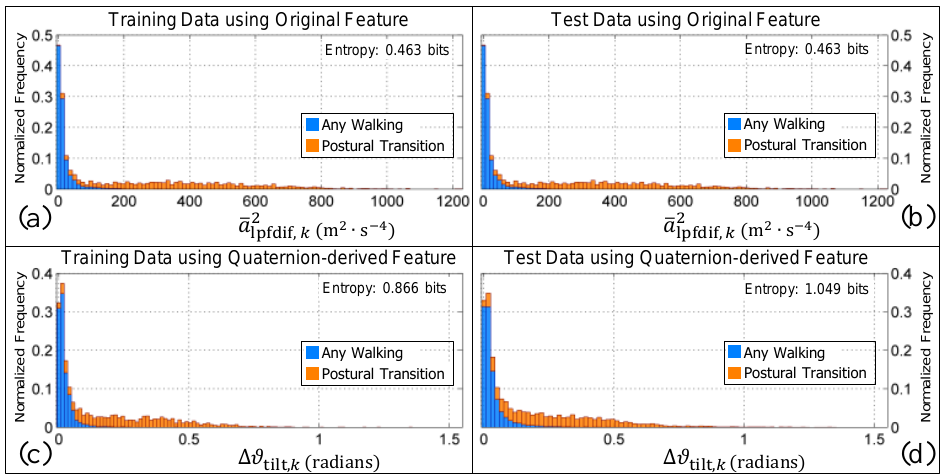
Figure 8. The normalized histograms of the walking (including walking up or down) and postural transition classes (illustrated in Figure 4) for the features ¯ a 2 and ∆ ¯ ϑ tilt, k . Panels ( a , c ) are the lpfdif, k histograms obtained when the training data are used (i.e., the data from the younger and older cohorts, respectively). Panels ( b , d ) are the histograms obtained when the test data are used (i.e., the data from the younger and older cohort after it had been re-oriented with each of the quaternions in Figure 1b–f). The bar charts in all panels are ‘stacked’. Note that the Shannon entropy for the original feature is consistently lower than the quaternion-derived feature which suggests that it will be better at distinguishing the activity classes.